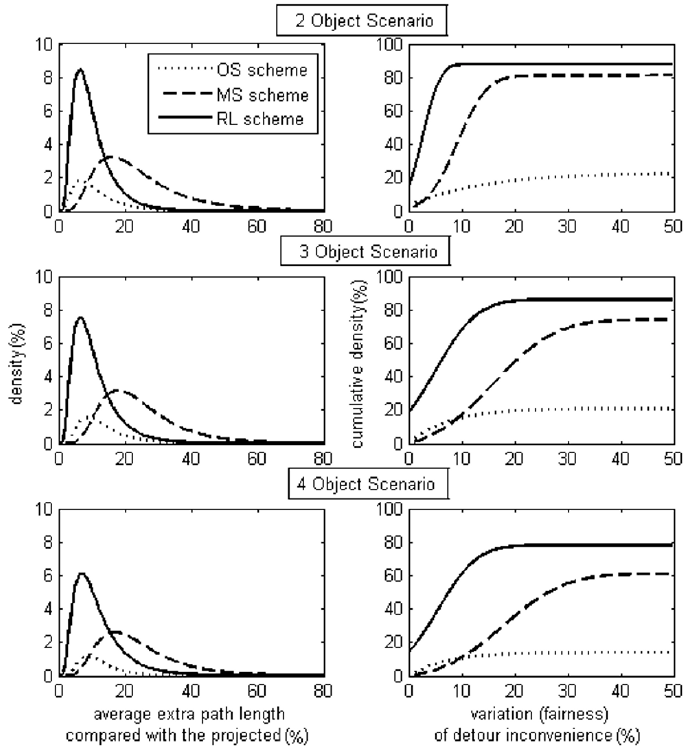
Figure 13. Comparison between schemes (Part